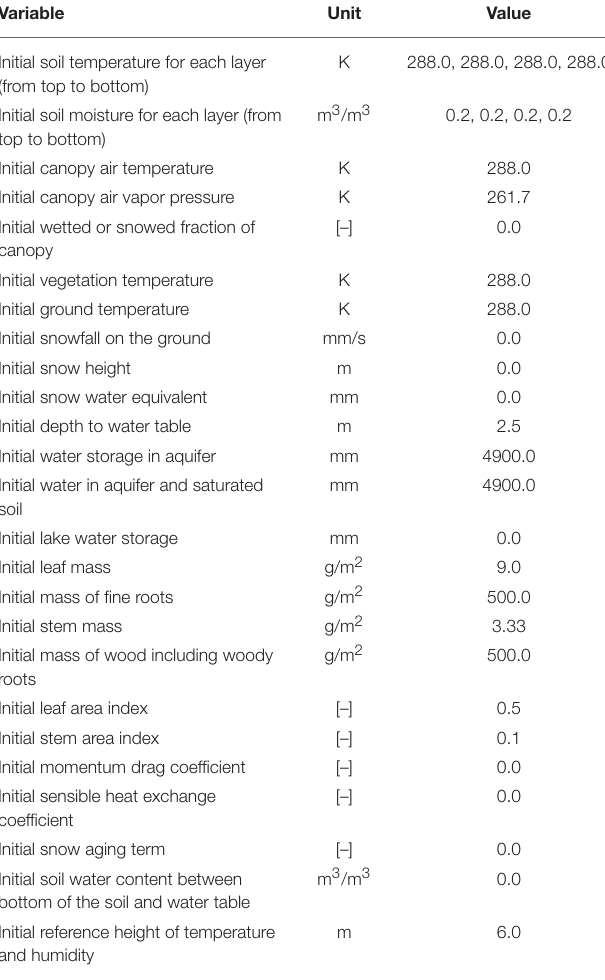
TABLE 2 | Initial conditions of model prognostic variables used for Noah-MP model run.